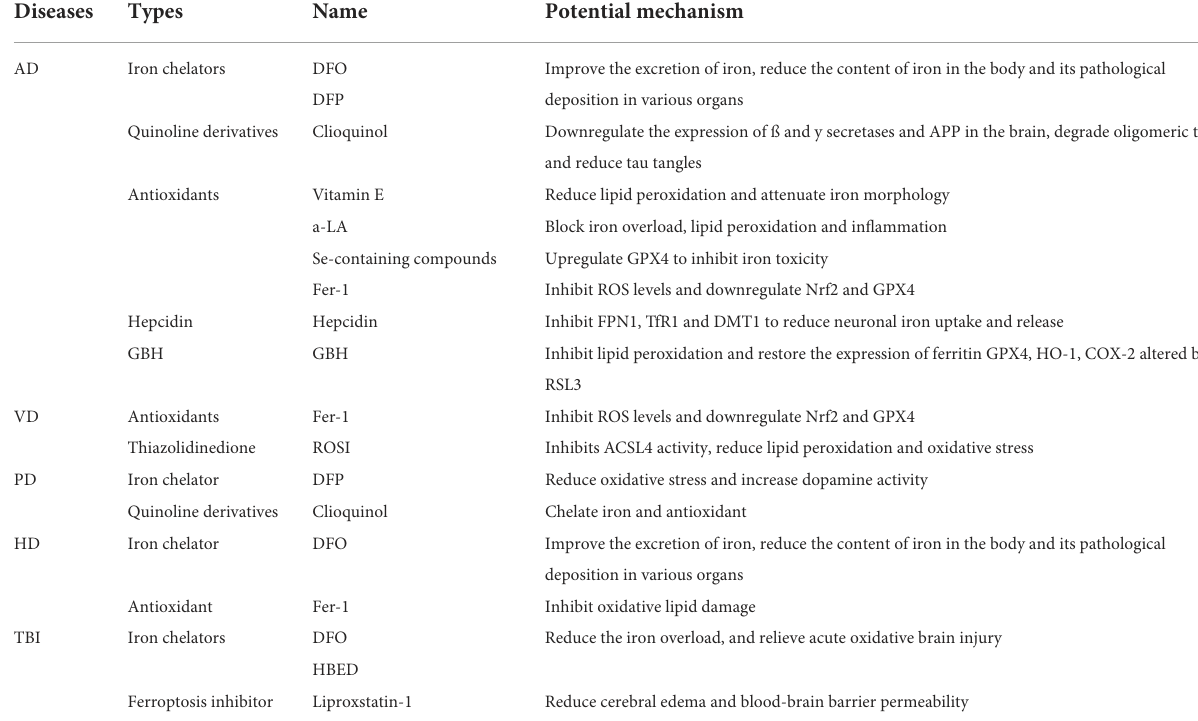
TABLE 1 Targeting ferroptosis for the potential treatment of neurodegenerative diseases.